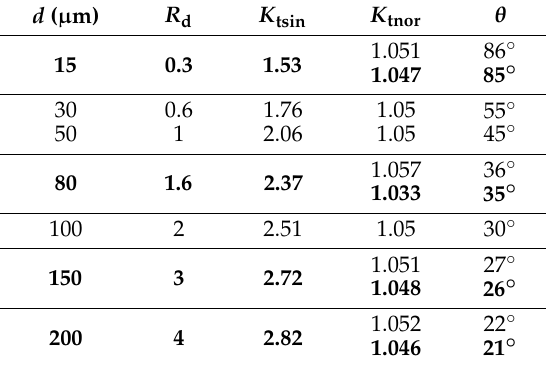
Table 2. The results of θ th for double adjacent pits ( λ = 1.1) with various pit depths. The newly obtained ones are presented in